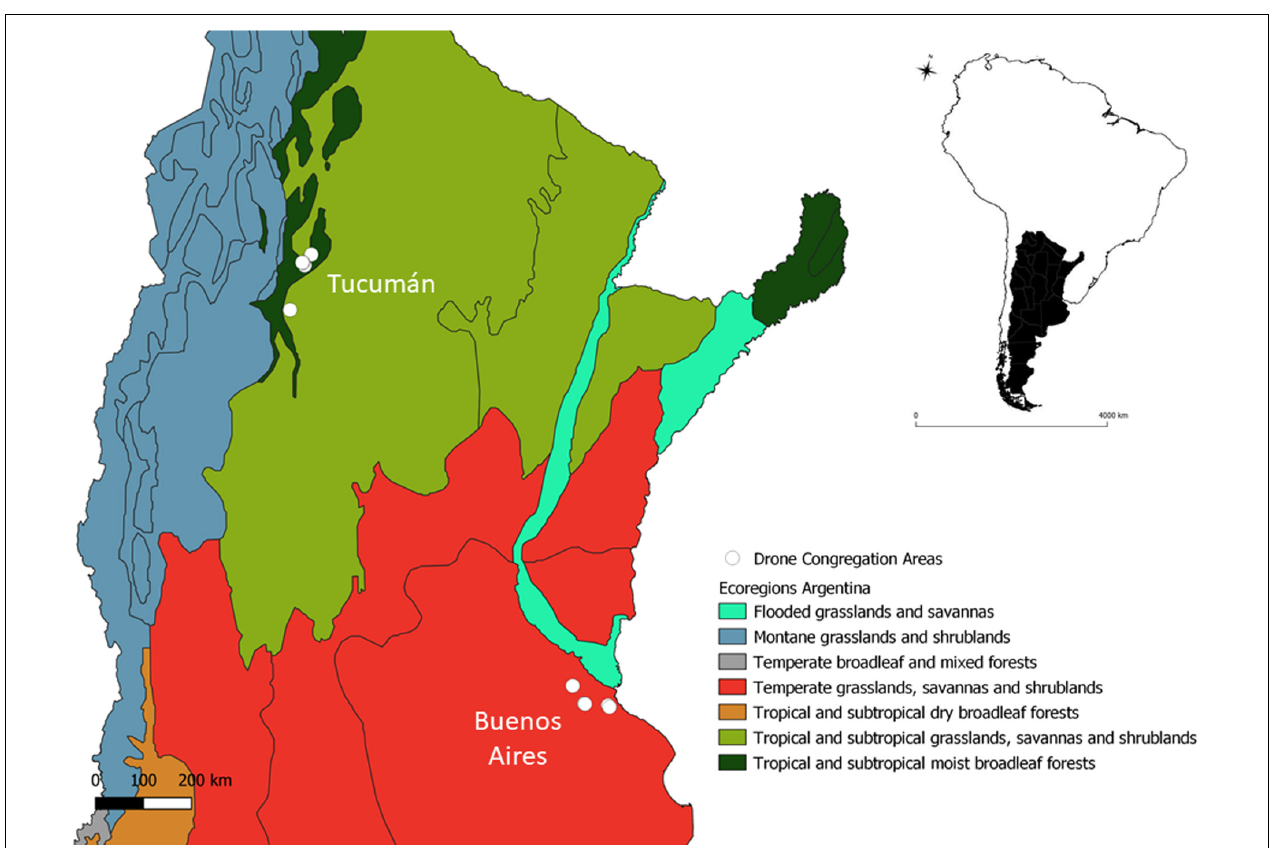
FIGURE 1 | Map of the study area showing the identified Drone Congregation Areas at the two eco-regions in Argentina. Eco-regions were defined according to Olson et al.